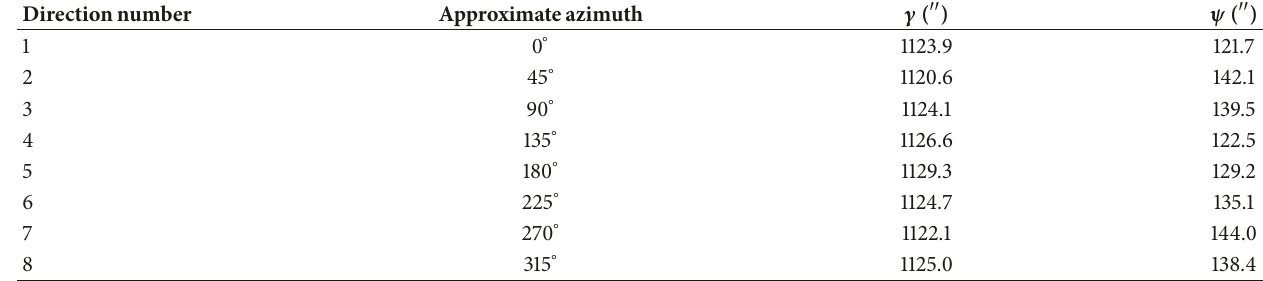
Table 3: Values of 𝛾 and 𝜓 in 8